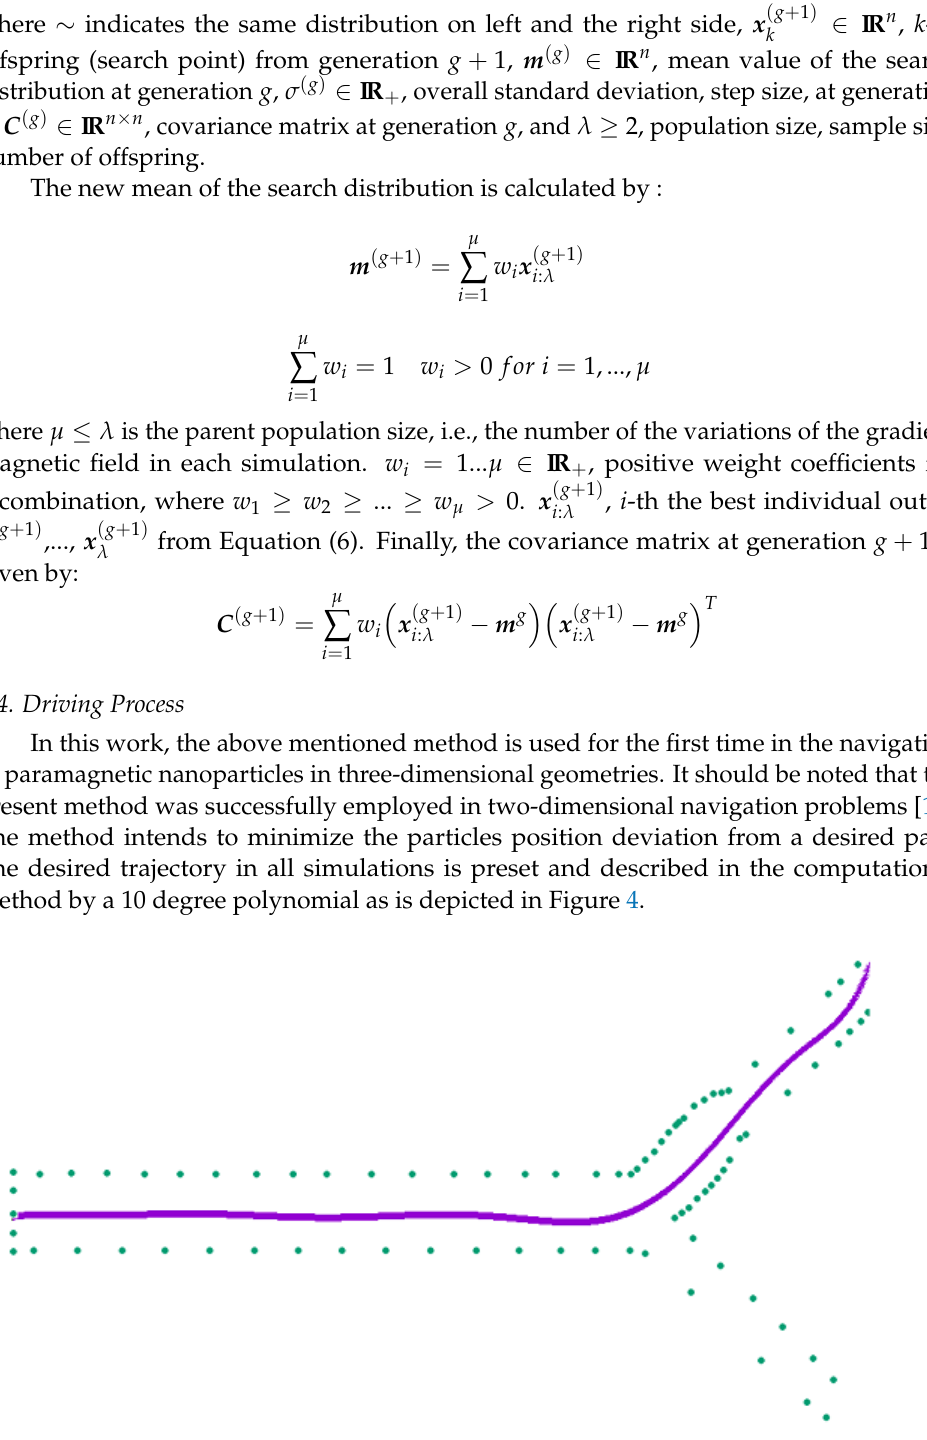
Figure 4. Projection of the carotid artery. Desired trajectory (purple line) and walls (green dots). Initially, blood flow in the carotid is achieved by suitably solving Equations (1) and (2). The non-Newtonian nature of blood’s viscosity is taken into consideration by solving Equation (3). Upon solving the flow and the pressure fields, the discrete phase simulation ( DEM ) starts by solving Equations (4) and (5). Blood loaded with particles enters the carotid from the left and splits into the two outlet branches at the right side of the domain (Figure 1).